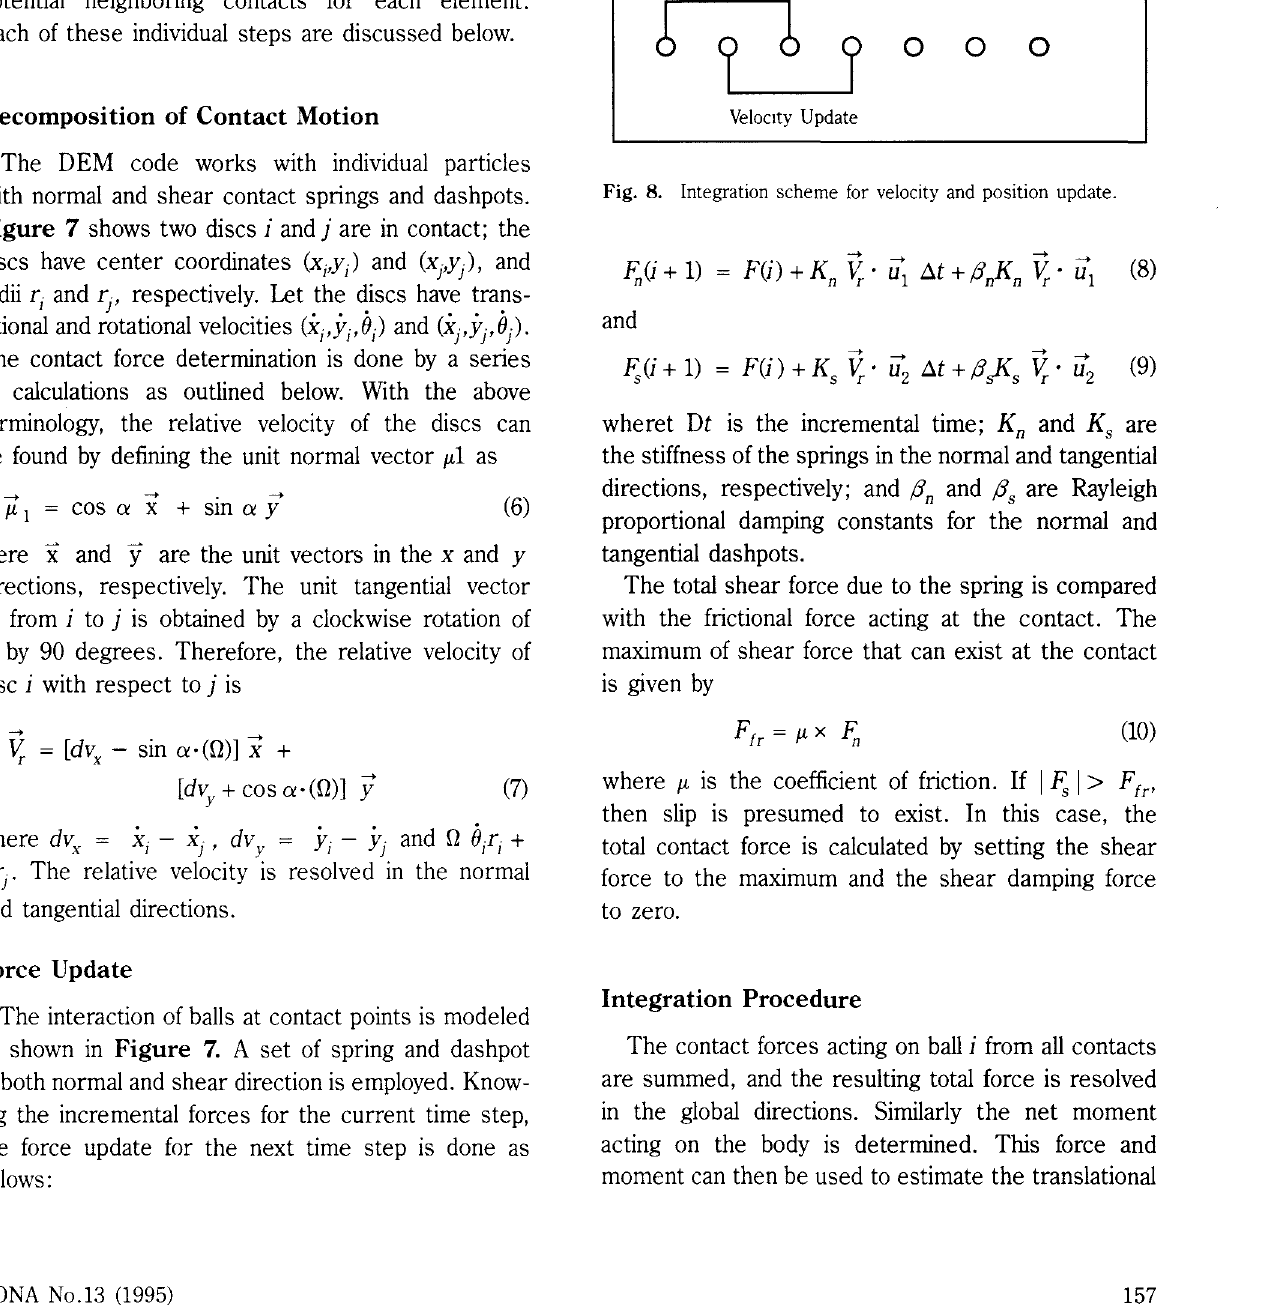
Fig. 8. Integration scheme for velocity and position